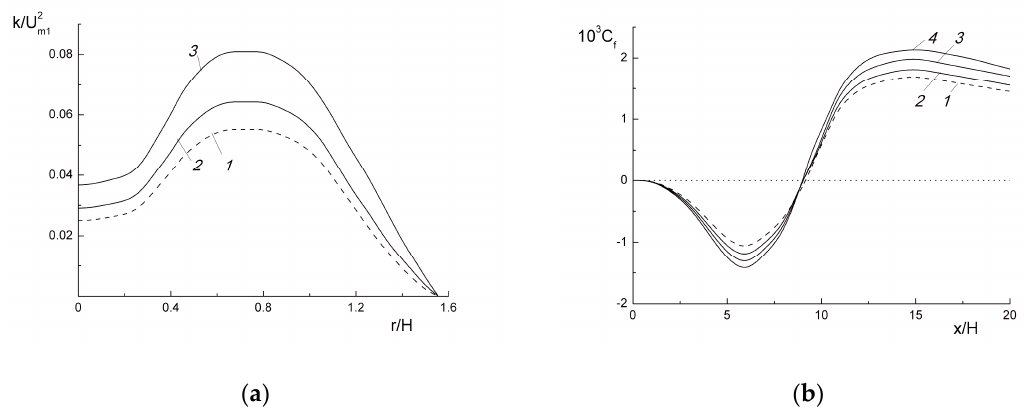
Figure 7. The profiles of TKE of the carrier fluid in radial direction at x / H = 5 ( a ) and wall friction coefficient ( b ). Re H = 2.09 × 10 4 , 2 R 1 = 15 mm, H = 13.5 mm, 2 R 2 = 42 mm, d = 1.7 mm. 1— β = 0 (one-phase water flow), 2— 3.5%, 3— 5.2%.